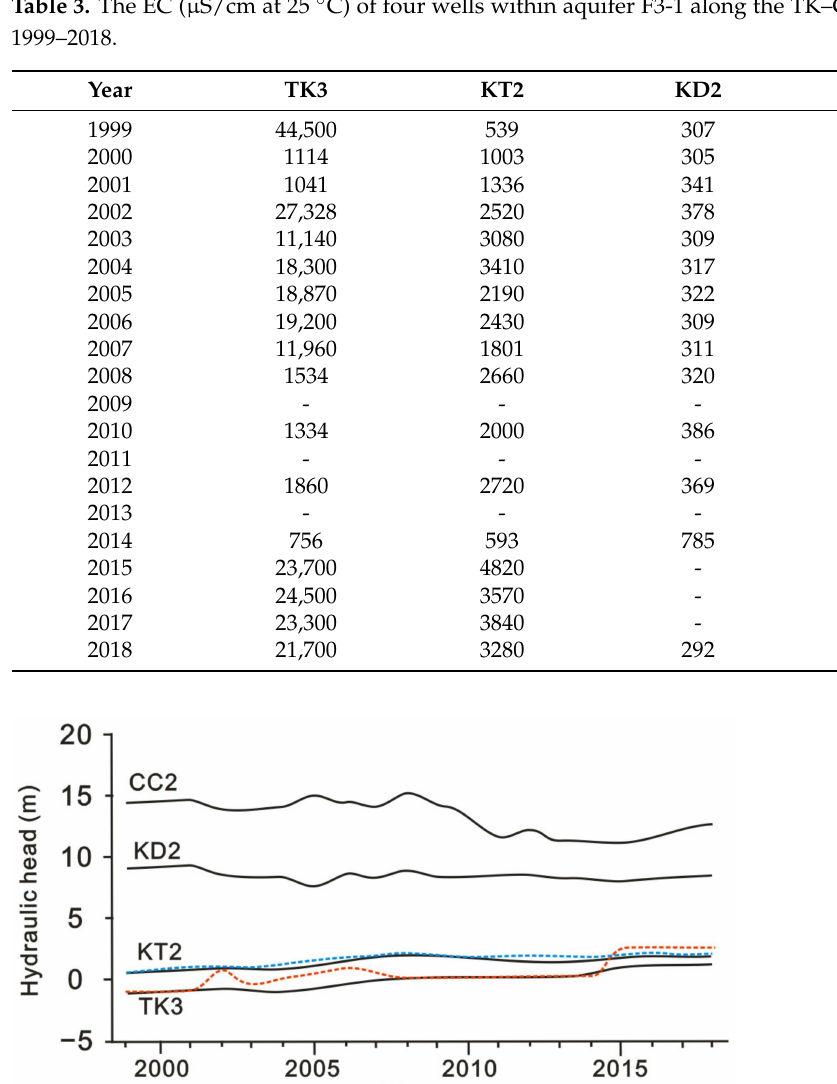
Table 3. The EC ( µ S/cm at 25 ◦ C) of four wells within aquifer F3-1 along the TK–CC profile from